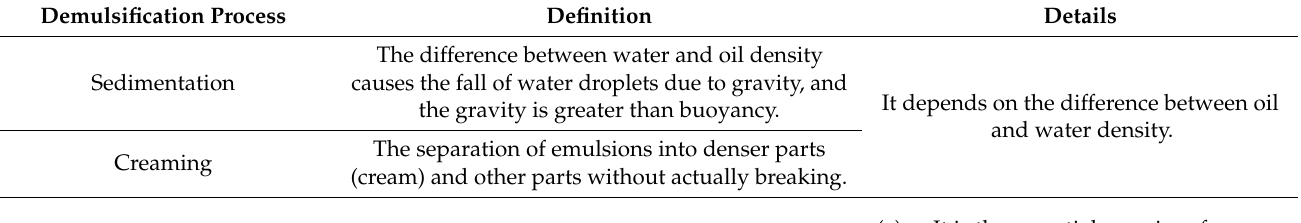
Table 9. Demulsification processes observed in W/O and O/W emulsions.